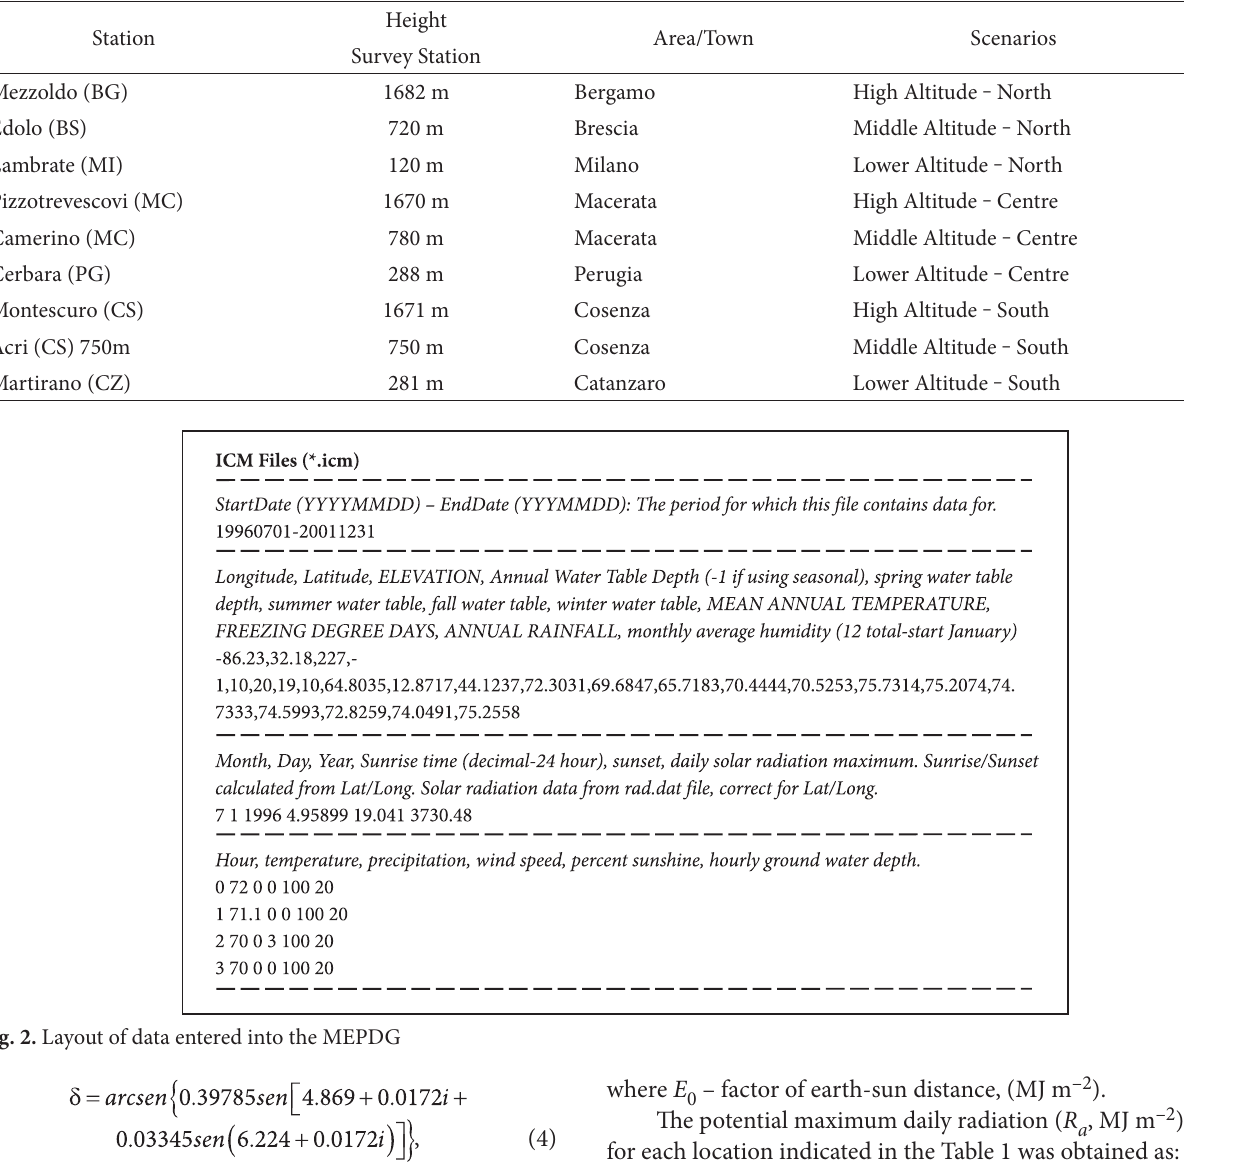
table 2. Survey stations